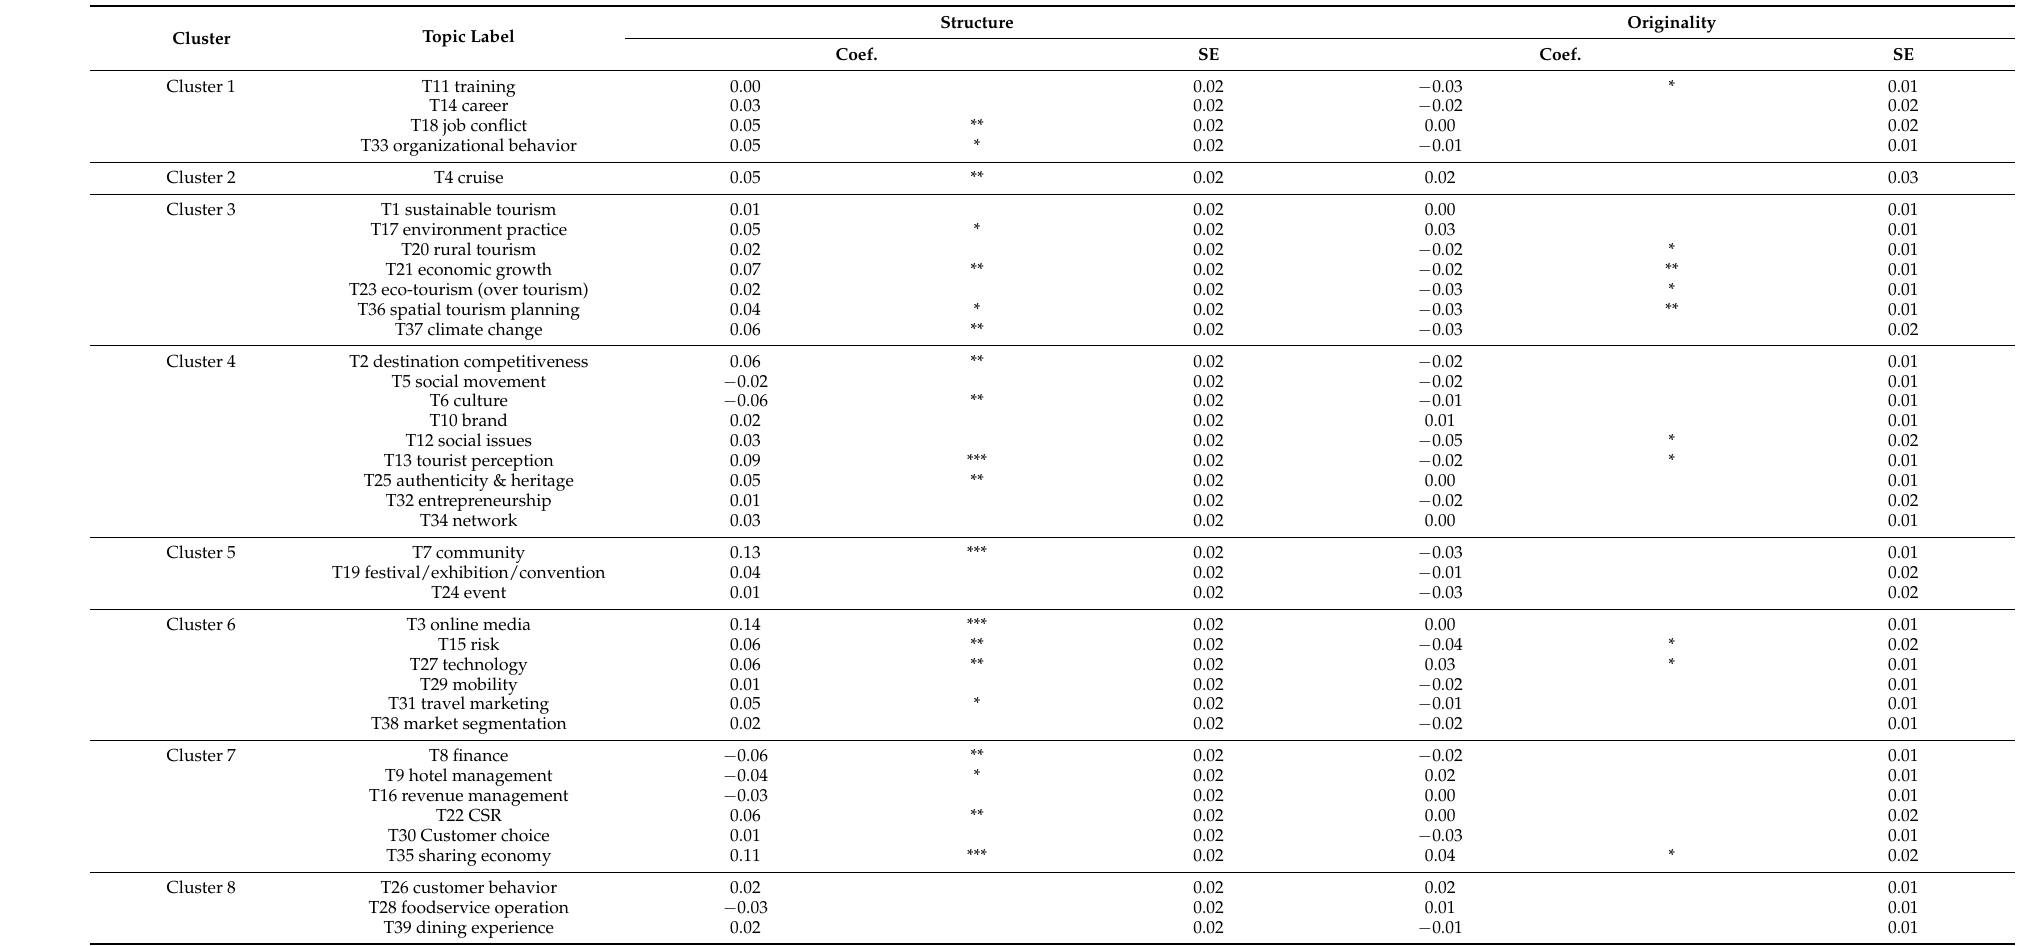
Table 4. Effects of topic structure and originality on scientific